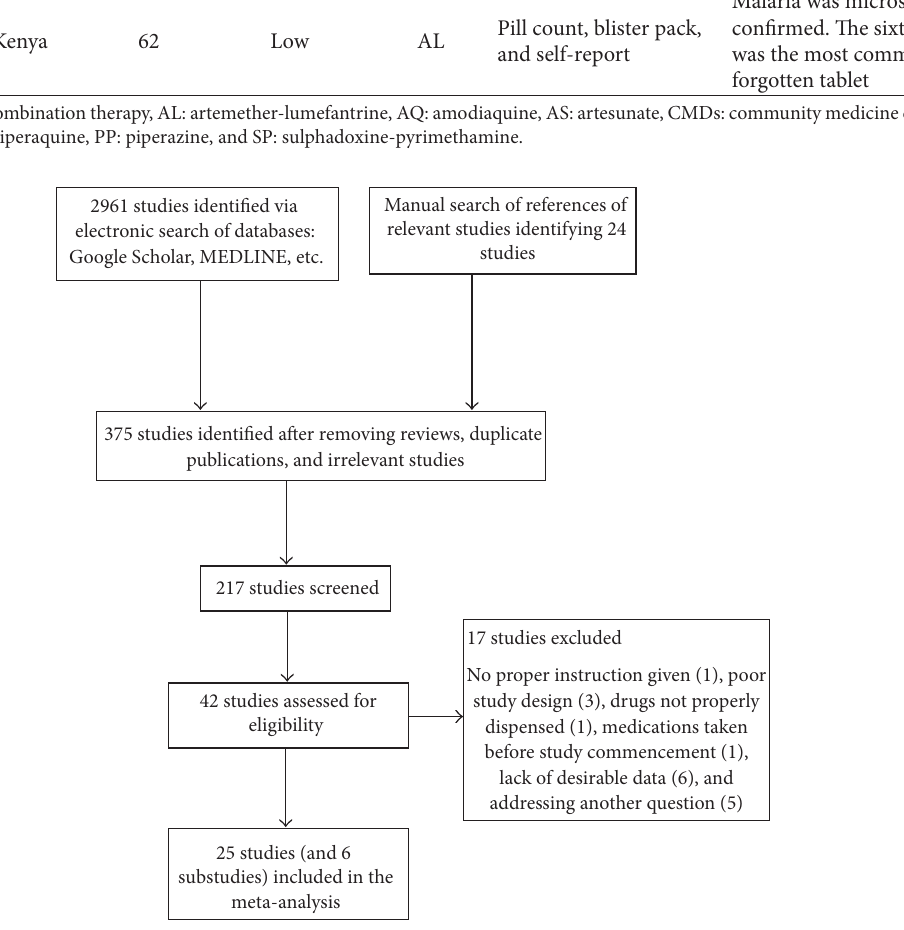
Figure 1: Flow diagram for selecting studies for review and